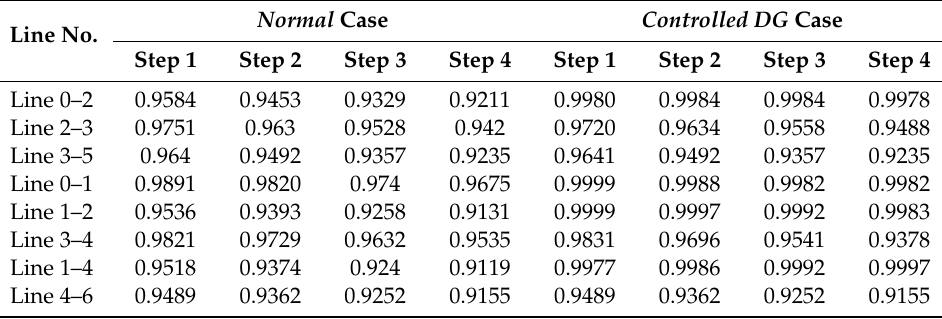
Table A8. Sending cos( ϕ ) values of lines for all steps and both cases.